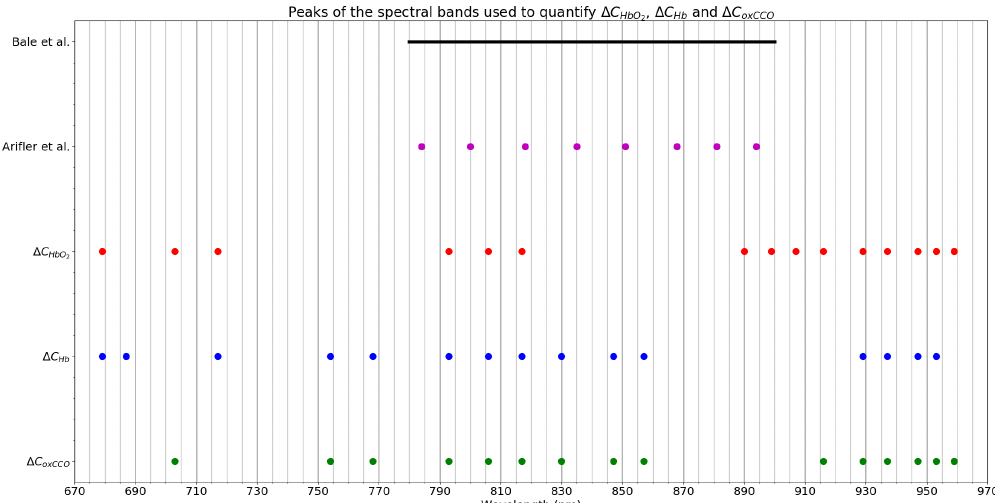
Figure 14. Peaks of spectral bands that minimize the quantification errors in ∆ C HbO